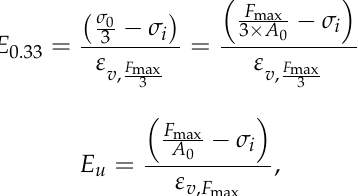
( b ) Figure 7. Compression tests: ( a ) C-01-S; ( b ) C-06-B.